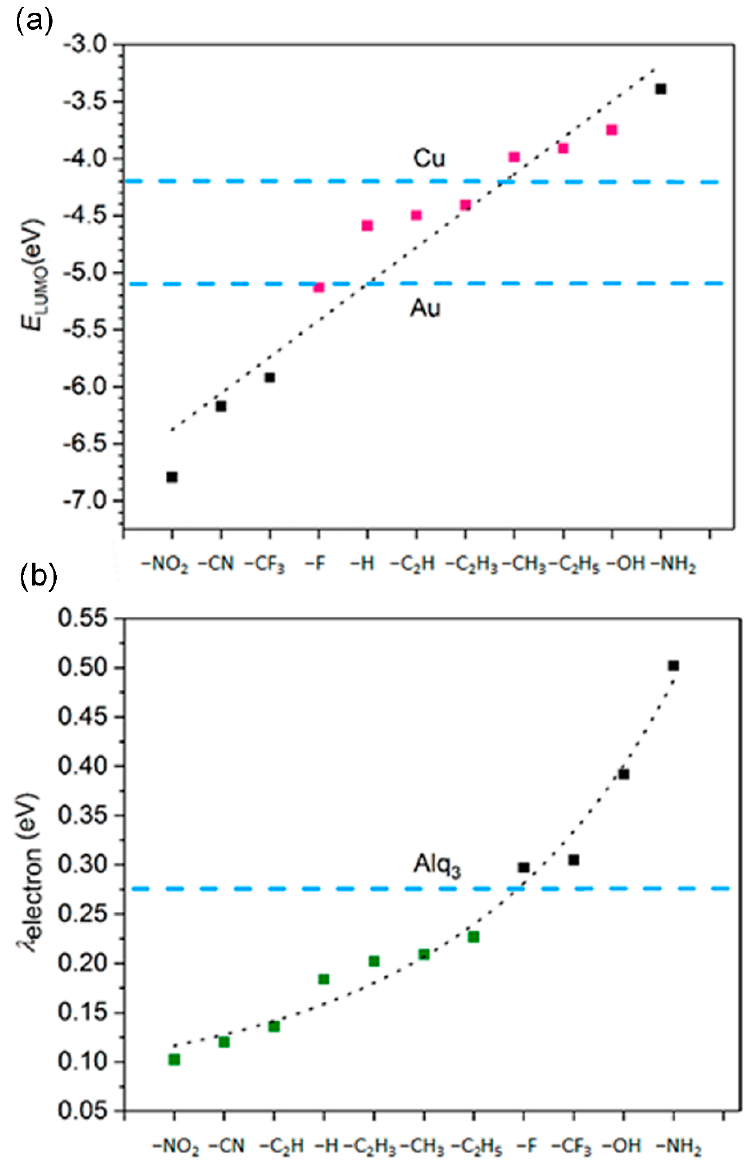
Figure 3. ( a ) Linear regression of the LUMO energies of substituted nickel dithiolenes with the Hammett’s constant of substituents. The blue dash line represents the work function of Au or Cu electrode. ( b ) The electron reorganization energies of substituted nickel dithiolenes, and the bluedash line represents the electron reorganization energy of the commonly used electron transportation layer material Alq3, which is the aluminum salt of Tris(8-hydroxyquinolin). Alq3 can be used as both organic electroluminescent materials and electron transportation layer materials.